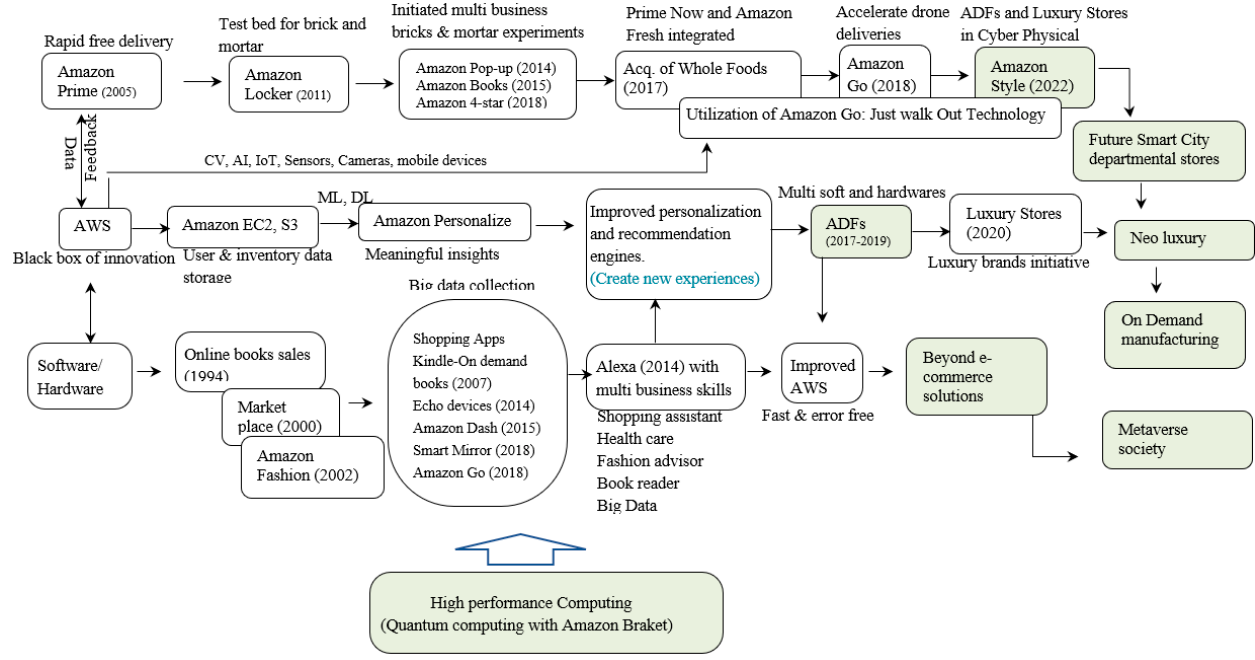
Figure 15. Learning orchestration beyond e-commerce.